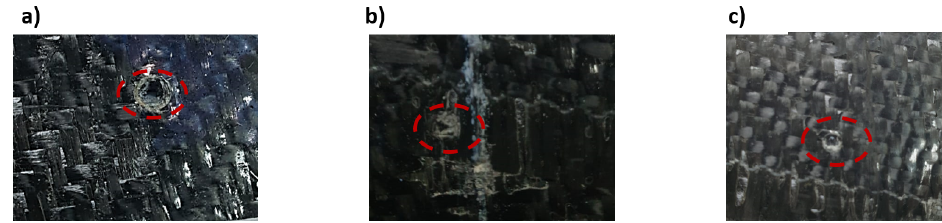
Figure 20. Tndentation though CFRP for ( a ) 1.9 J, ( b ) 2.7 J, and ( c ) 3.4 J.